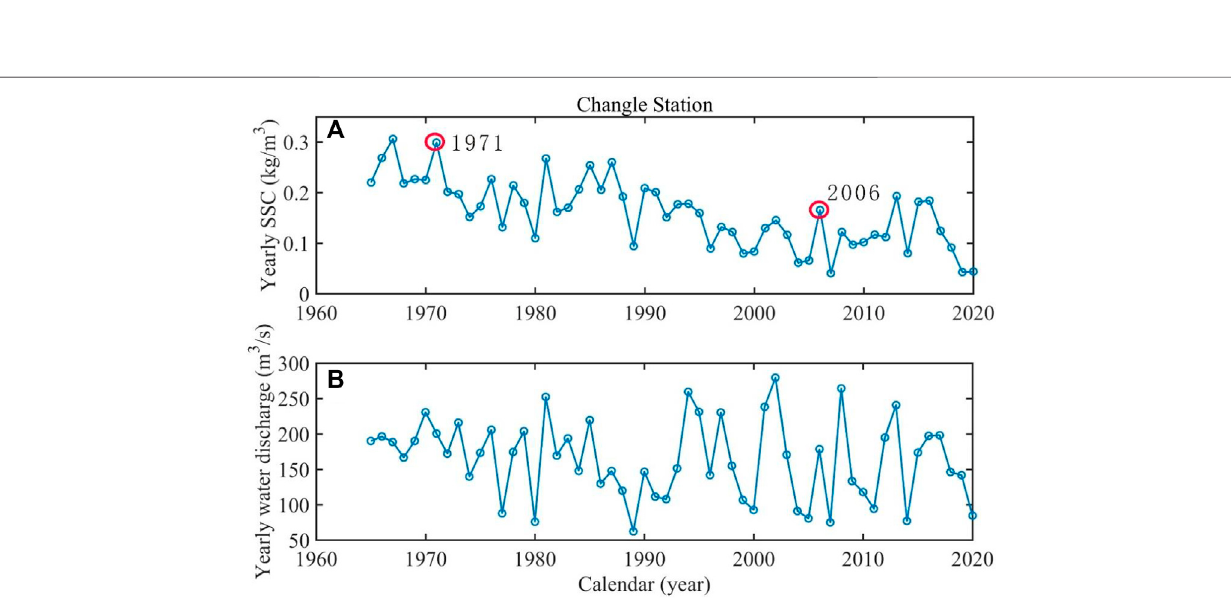
Frontiers in Earth Science |